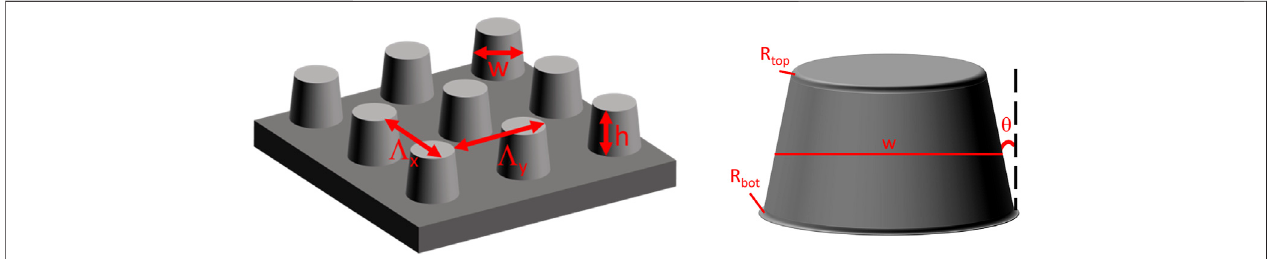
FIGURE1 | Illustration ofthetruncatedcone model and the parameterization used todescribe thephysical sample. The parameters (periods, Λ x and Λ y , height, h , and width, w ) speci fi ed by the manufacturer are shown on the left, while the additional parameters used (sidewall angles, θ , and corner rounding radii, R top and R bot ) are shown on the right. The width is de fi ned as the full-width-half-max of the cone.